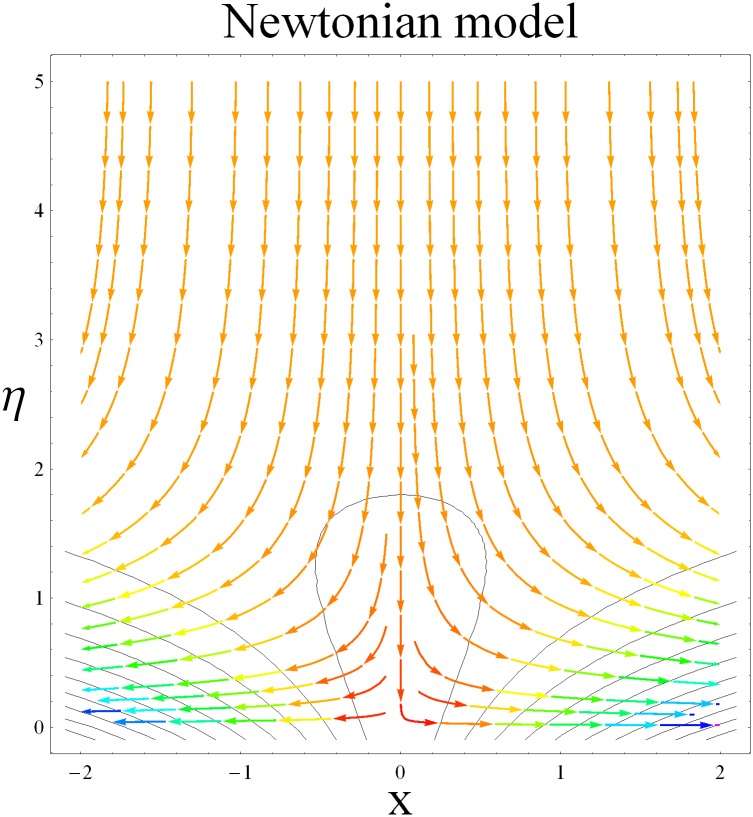
Stream lines for Newtonian model.